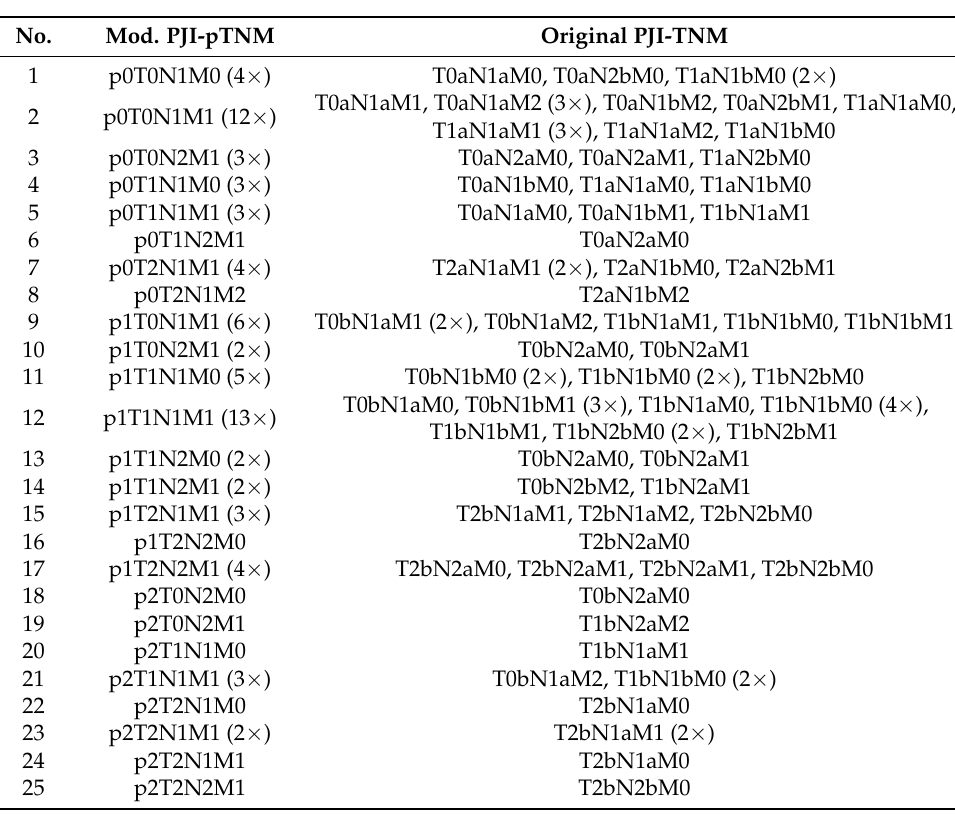
Table 5. Comparison of cases between original “TNM” and modified “pTNM” classification according to the 80 cases analyzed in this